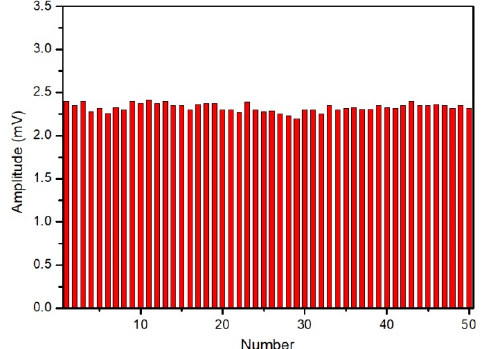
Figure 5. Signal stability curve in mixing process.